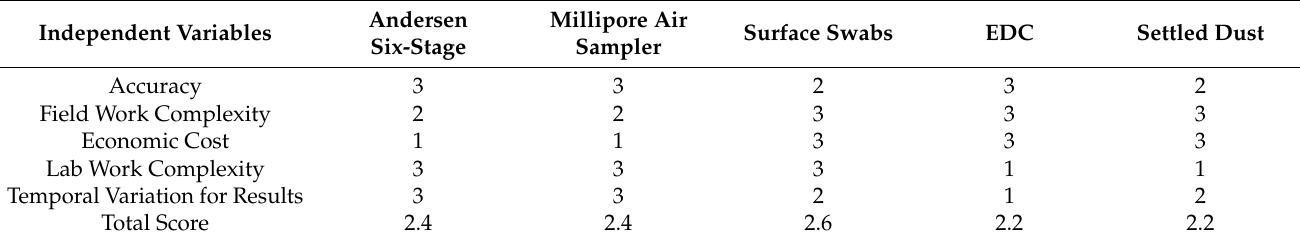
Table 3. Average scores of the five selected criteria for all the sampling methods